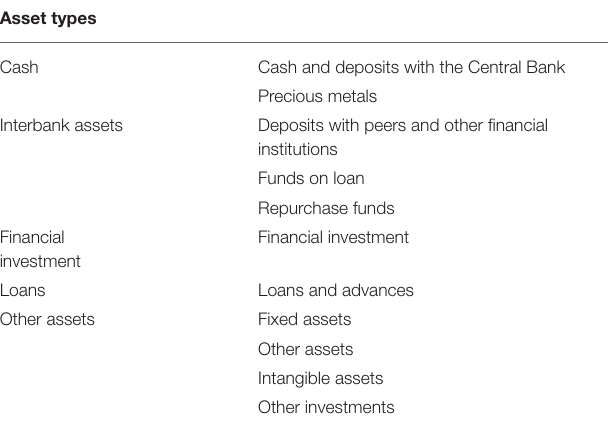
TABLE 1 | Asset classes of Chinese